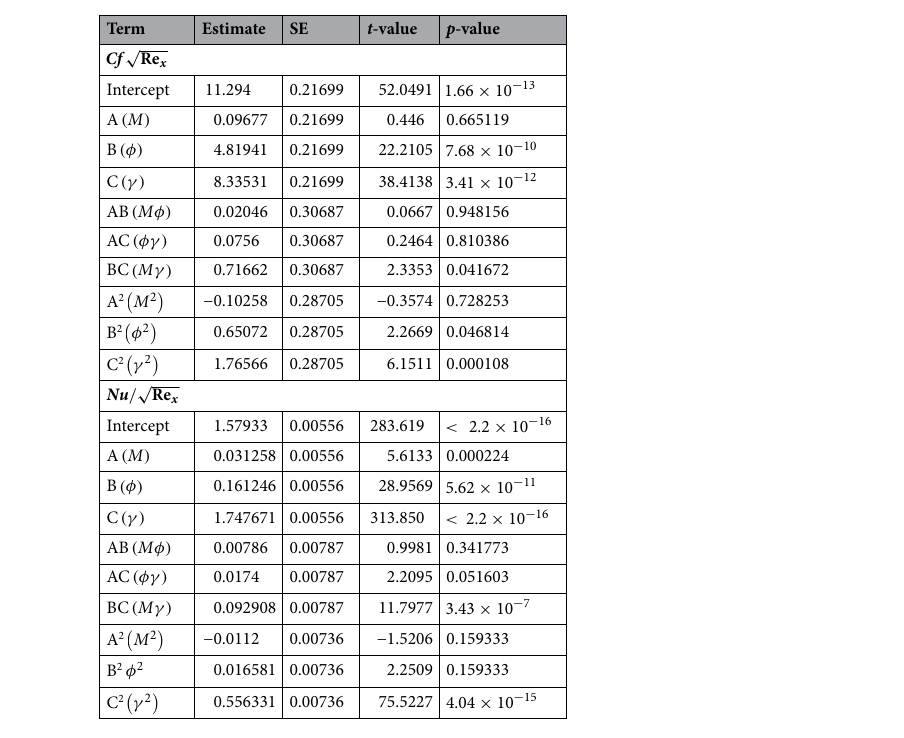
Table 5. Evaluations of fitted model terms, along with t -value and p